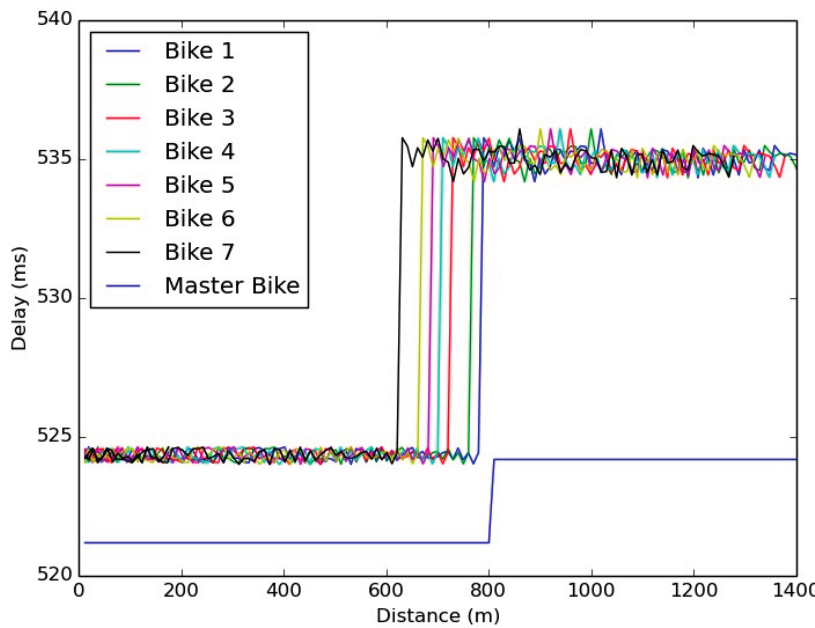
Figure 2. Bike reception delay.